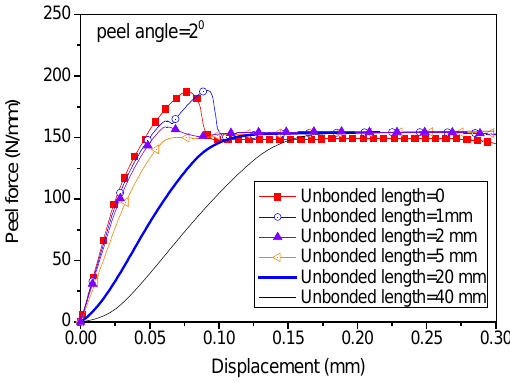
Figure 8. Effect of different unbonded lengths of FRP lamina on the load-displacement behavior (peel angle = 2 degree).